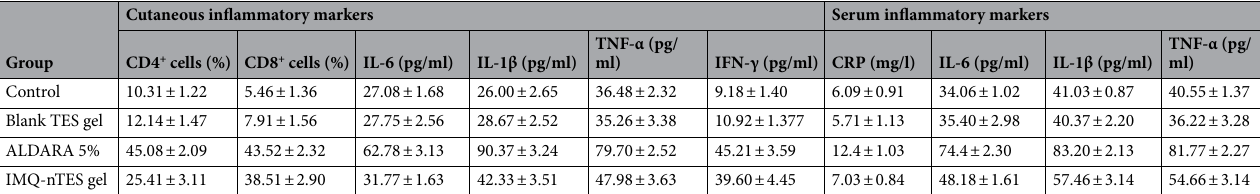
Table 8. Summary of cutaneous and systemic immune response in ALDARA, IMQ-nTES gel, and control group. All values are stated as mean ± S.D (n =